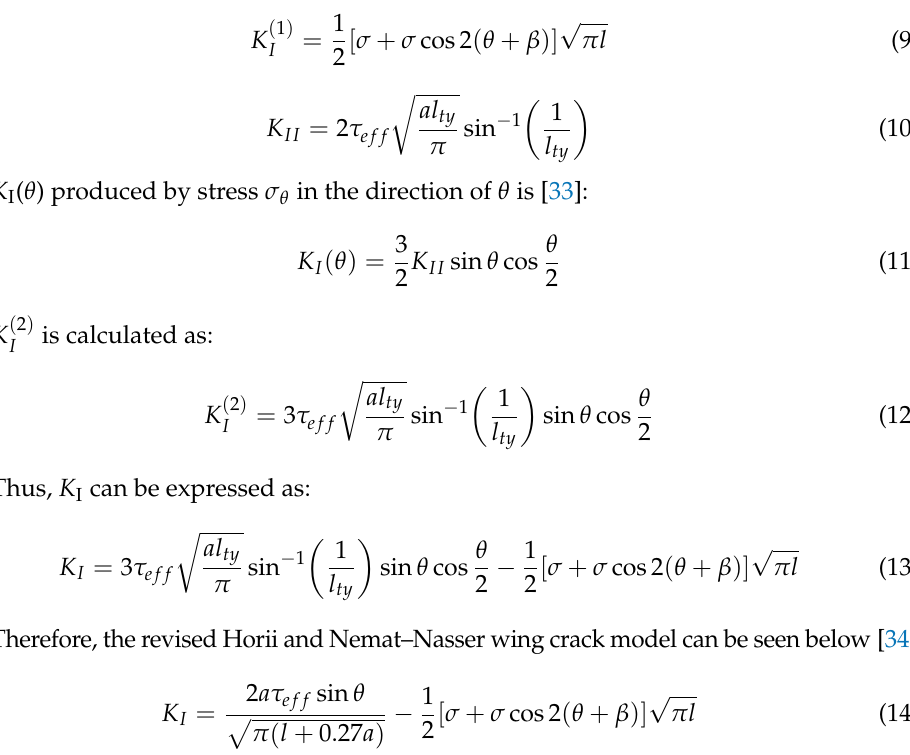
( 2 ) is introduced ( ) 2 I K Ι is intro-